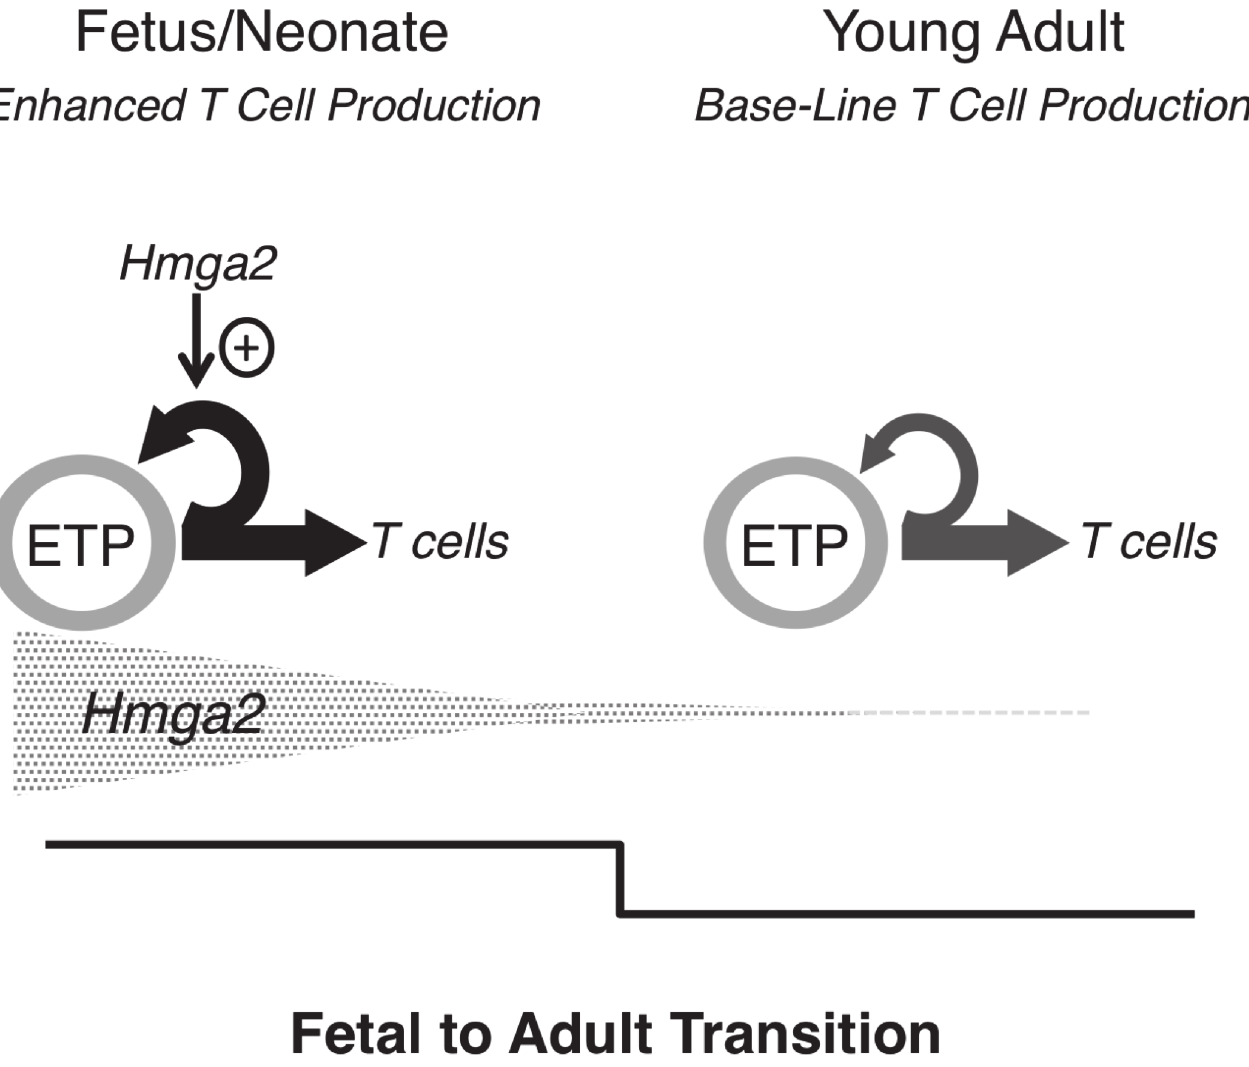
Fig 6. Model of how Hmga2 expression affects cell production in the fetal and young adult thymus. During the fetal/neonatal phase of thymopoiesis, high levels of Hmga2 contribute to efficient maintenance of the ETP compartment, possibly through enhanced proliferation and/or self-renewal. This in turn contributes to the high rate of cell production in the fetal/neonatal thymus. During the transition from the fetus/neonate to the young adult, there is a sharp down-regulation of Hmga2 expression in ETP which contributes to the diminution in the tempo of thymopoiesis to steady state adult